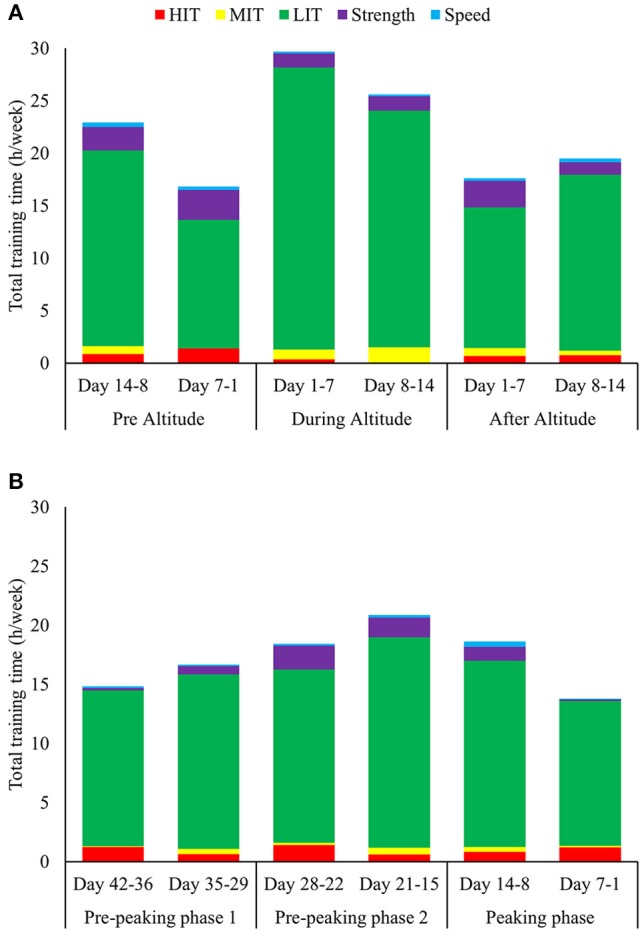
(A,B) Total weekly training distributions of (A) the 2 weeks before-, 2 weeks during- and 2 weeks after the annual altitude camp in October, and (B) the final 6 weeks before the four international championships performed in February during the period from 2010–2015, distributed into endurance training (low-, moderate-, and high-intensity), strength- and speed training.